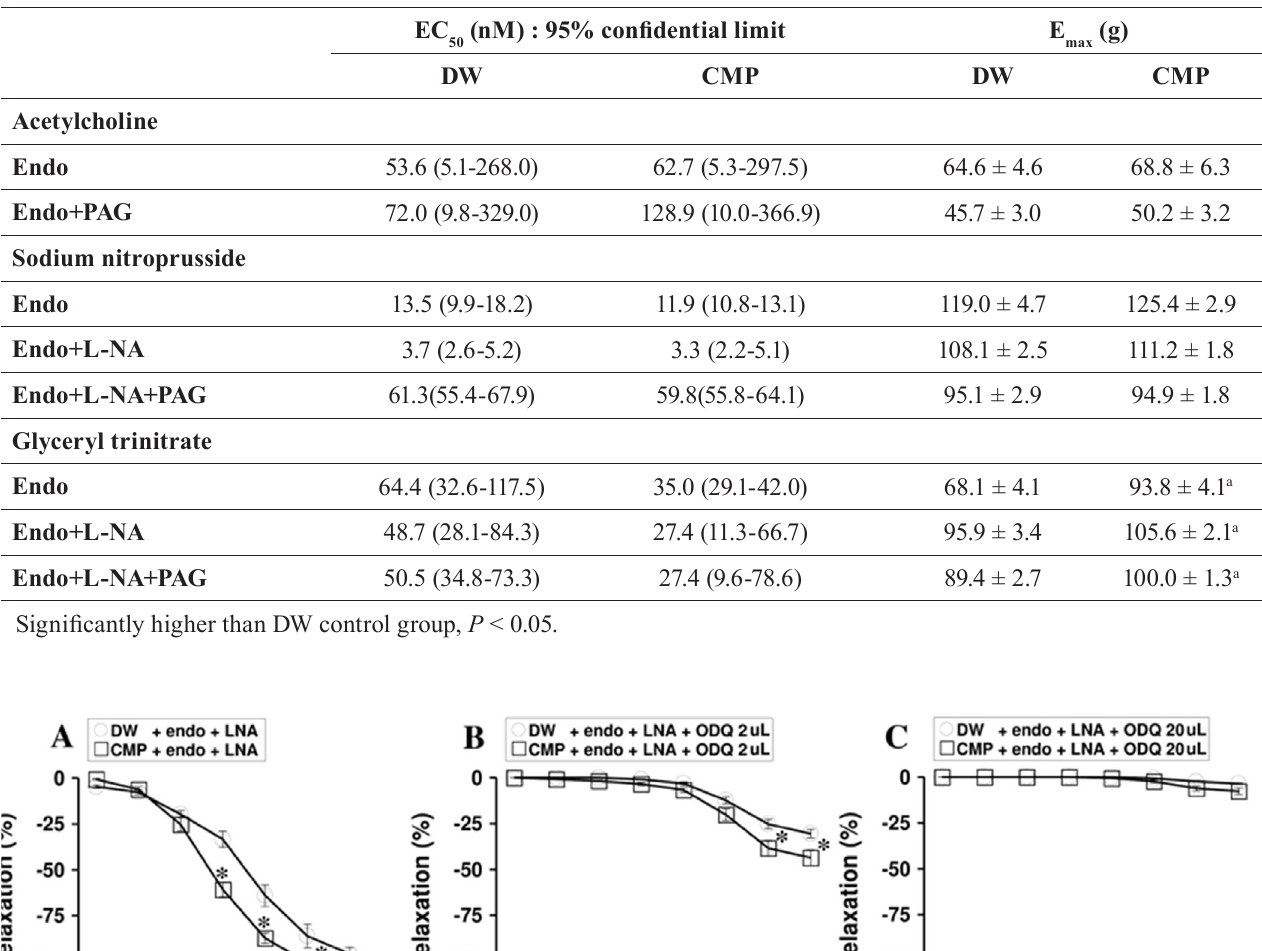
TABLE III - Effects of CMP (1 g/kg) or distilled water (DW) consumption by middle-aged male rats on EC of acetylcholine, sodium nitroprusside or glyceryl trinitrate on relaxation of the endothelial-intact (Endo) aortic rings in the absence or presence of N-nitro-L-arginine (L-NA) and/or DL-propargylglycine (PAG)